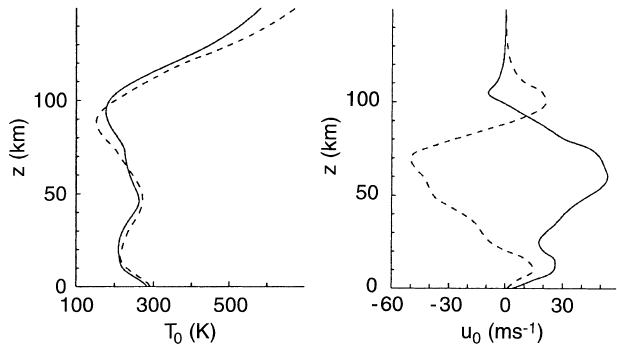
Fig. 3. Vertical profiles of the mean temperature, T 0 , and zonal wind, u 0 , for January ( solid lines ) and July ( dashed lines ) at latitude 45 (cid:14) N (Hedin, 1991). Positive values of u 0 correspond to the eastern